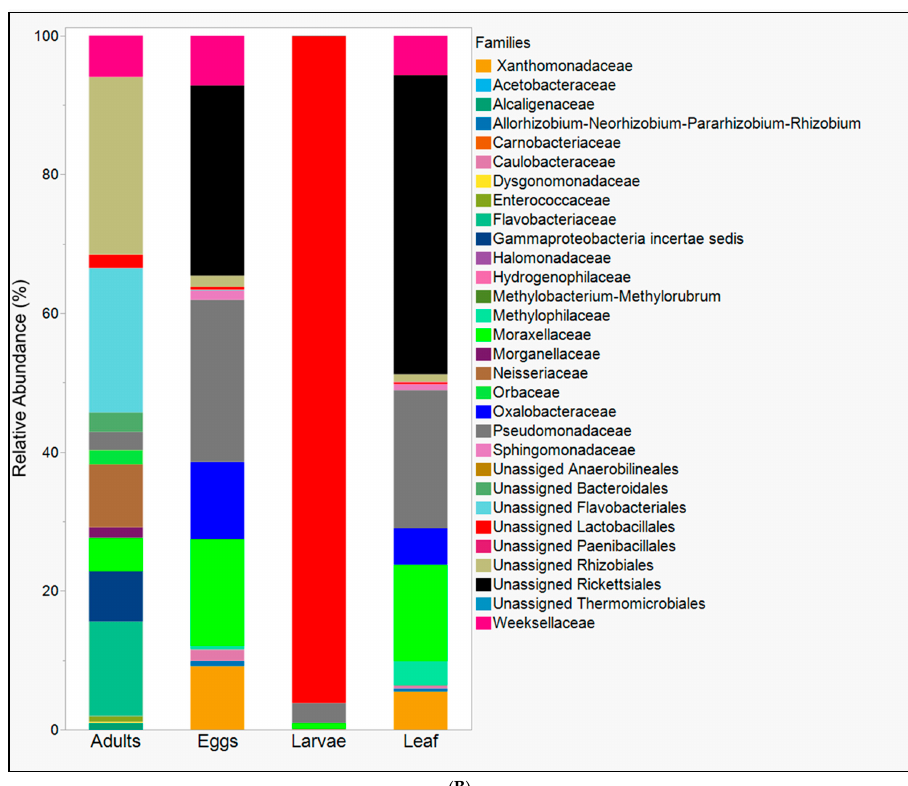
Figure 2. Microbiota differences across field-collected western bean cutworm Striacosta albicosta de- velopmental stages and its dietary material. Differentially abundant microbial ( A ) phyla and ( B ) families ( p < 0.05) across developmental stages. ( B ) families ( p < 0.05) across developmental